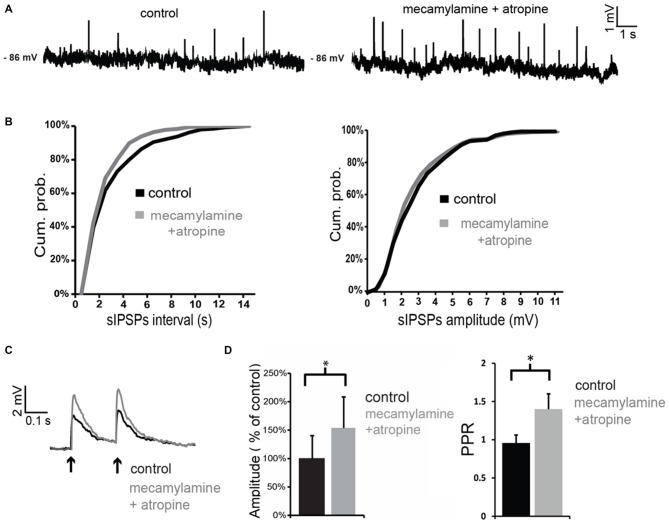
Co-application of nicotinic and muscarinic antagonists increases GABAergic inputs to LTS interneurons. (A) Co-application of mecamylamine and atropine increased the frequency of spontaneous GABAergic events in a LTS interneuron. (B) Quantification of the effects of co-application of mecamylamine and atropine on frequency and amplitude of spontaneous GABAergic events in the interneuron of panel (A). The frequency, but not the amplitude, of spontaneous IPSPs was significantly (p < 0.05 for inter-event intervals) increased by the antagonists. (C) The amplitude of evoked GABAergic IPSPs was significantly increased by co-application of mecamylamine and atropine in a LTS interneuron. Traces are average of five consecutive events evoked by paired-pulse stimulation (200 ms intervals) delivered every 10 s. (D) Average effects of co-application of mecamylamine and atropine on the amplitude of the first evoked GABAergic PSP and on PPR. For each experiment, the amplitude of GABA responses in the presence of atropine and mecamylamine was expressed as percentage of average GABA response amplitude in control solution. Asterisks indicate statistical significance at p < 0.05.